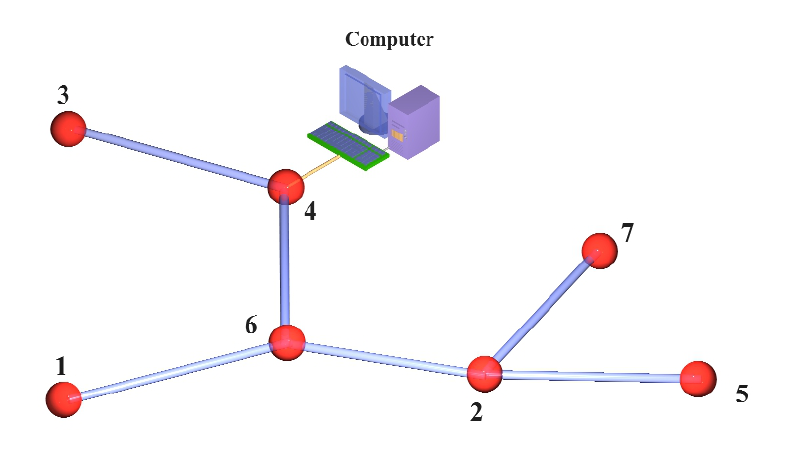
Figure 4. Illustration of a sensor network. The nodes are represented by red spheres, and the communication links represented by blue lines. The numbers indicate node